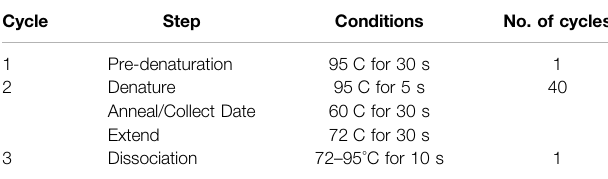
TABLE 1 | RT-PCR reaction